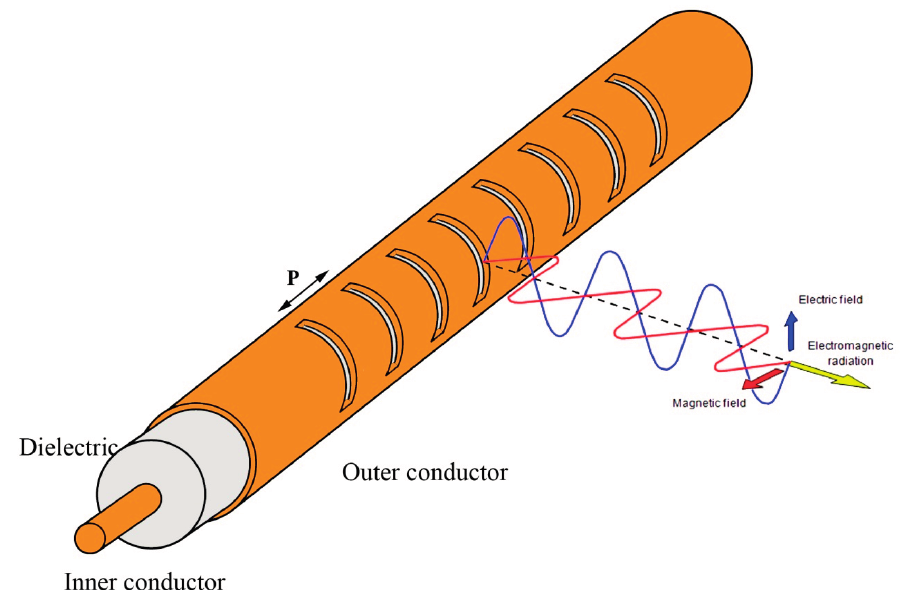
Figure 2. Schematic of the leaky coaxial antenna